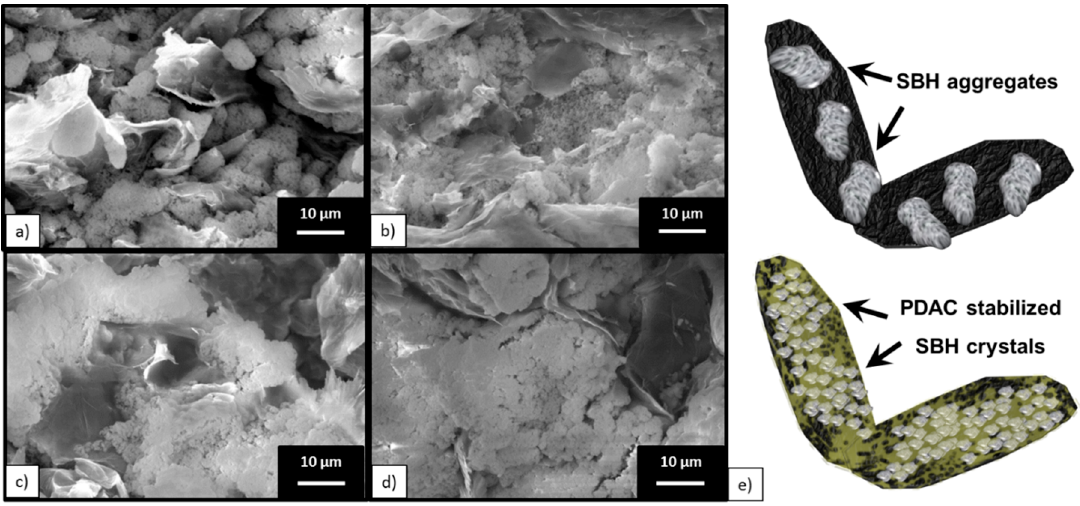
Figure 2. SEM representative images of samples cross sections. ( a ) Strontium bromide hexahydrate/expanded natural graphite (SBH/G), ( b ) SBH/G/P(0.1), ( c ) SBH/G/P(0.5) ( d ) SBH/G/P(1). ( e ) Illustration of the polydiallyldimethylammonium chloride (PDAC) effect in the SBH/G mixture.